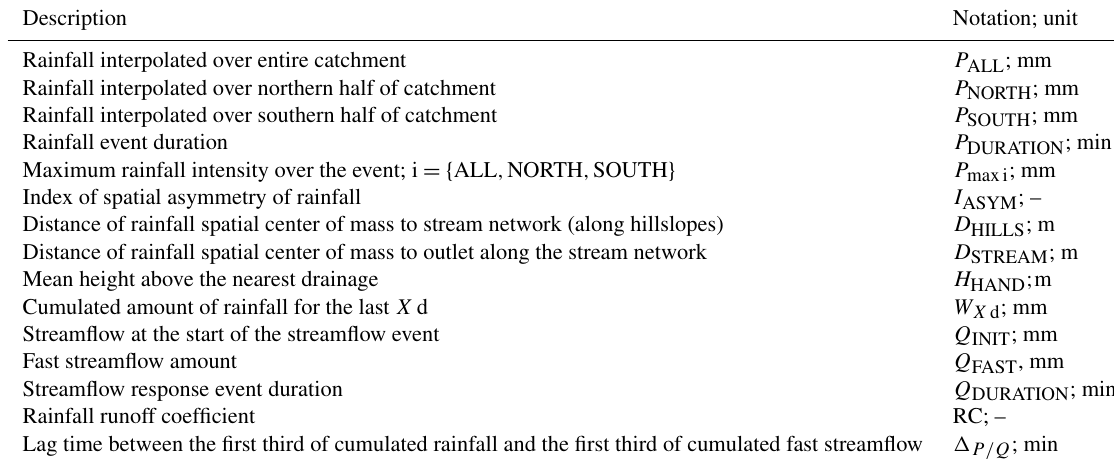
Table 1. List of used metrics, with corresponding parameter name or abbreviation. Description Notation; unit Rainfall interpolated over entire catchment P ALL ; mm Rainfall interpolated over northern half of catchment P NORTH ; mm Rainfall interpolated over southern half of catchment P SOUTH ; mm Rainfall event duration P DURATION ; min Maximum rainfall intensity over the event; i = { ALL , NORTH , SOUTH } P maxi ; mm Index of spatial asymmetry of rainfall I ASYM ; – Distance of rainfall spatial center of mass to stream network (along hillslopes) D HILLS ; m Distance of rainfall spatial center of mass to outlet along the stream network D STREAM ; m Mean height above the nearest drainage H HAND ; m Cumulated amount of rainfall for the last X d W X d ; mm Streamflow at the start of the streamflow event Q INIT ; mm Fast streamflow amount Q FAST , mm Streamflow response event duration Q DURATION ; min Rainfall runoff coefficient RC;